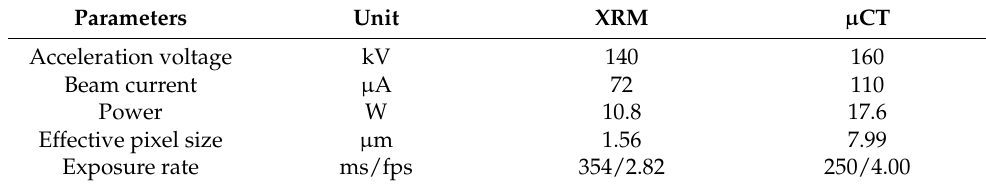
Table 3. Parameters for XRM of the powder particles and µ CT scans of the PBF-LB specimens. Parameters Unit XRM Acceleration